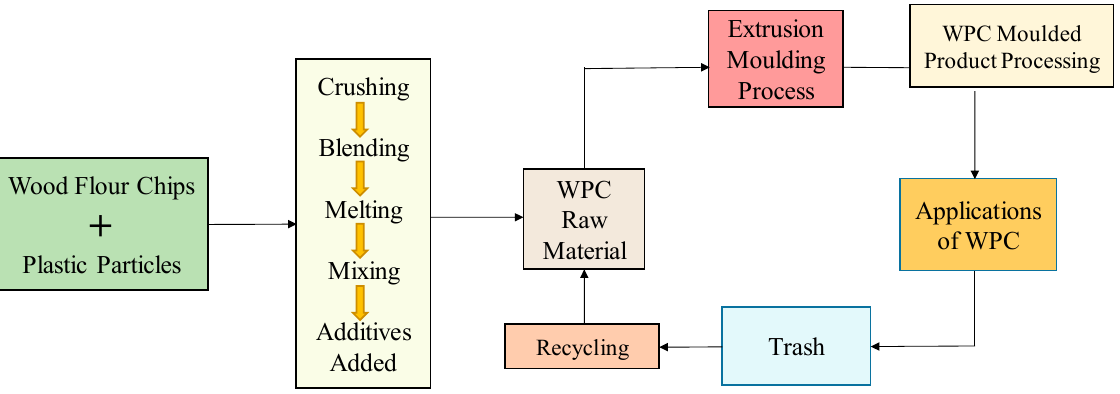
Figure 5. Process flowchart of WPC manufacturing process with extrusion system.